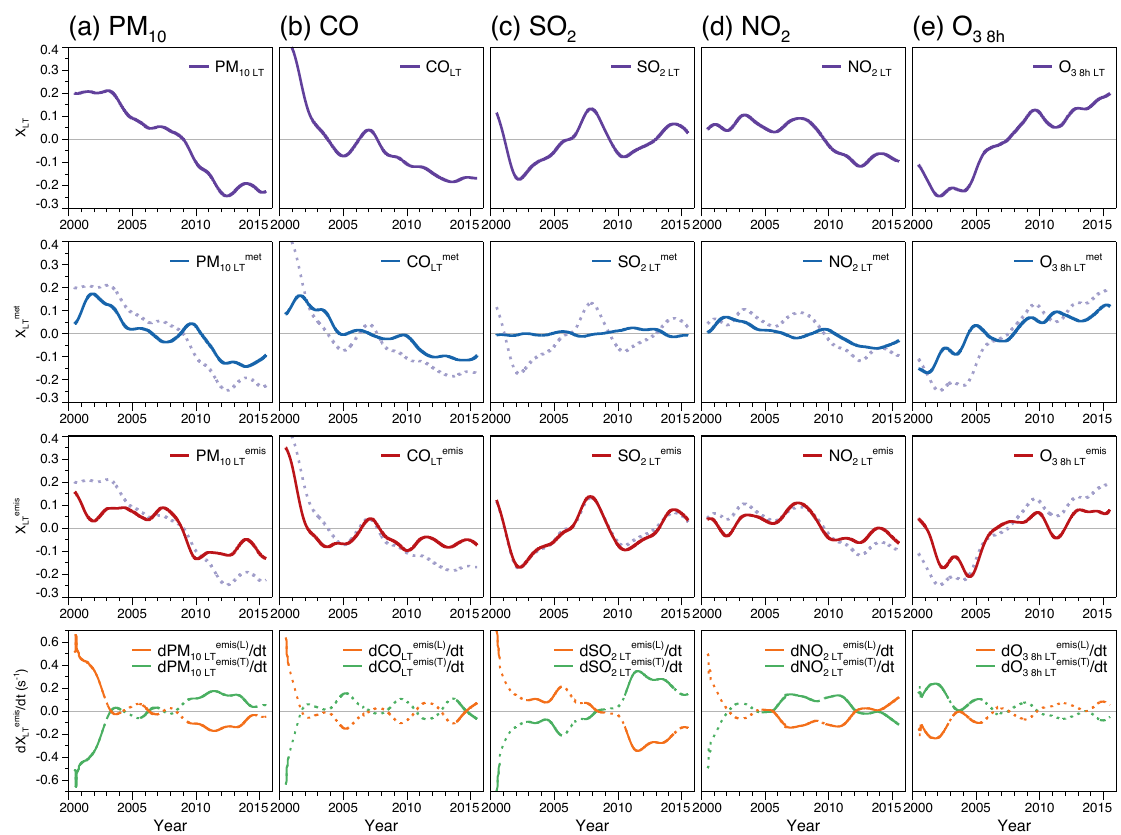
; blue lines (cid:1) LT (cid:16) ∂ (cid:17) ; orange lines X emis ( L ) and trans- LT ∂t